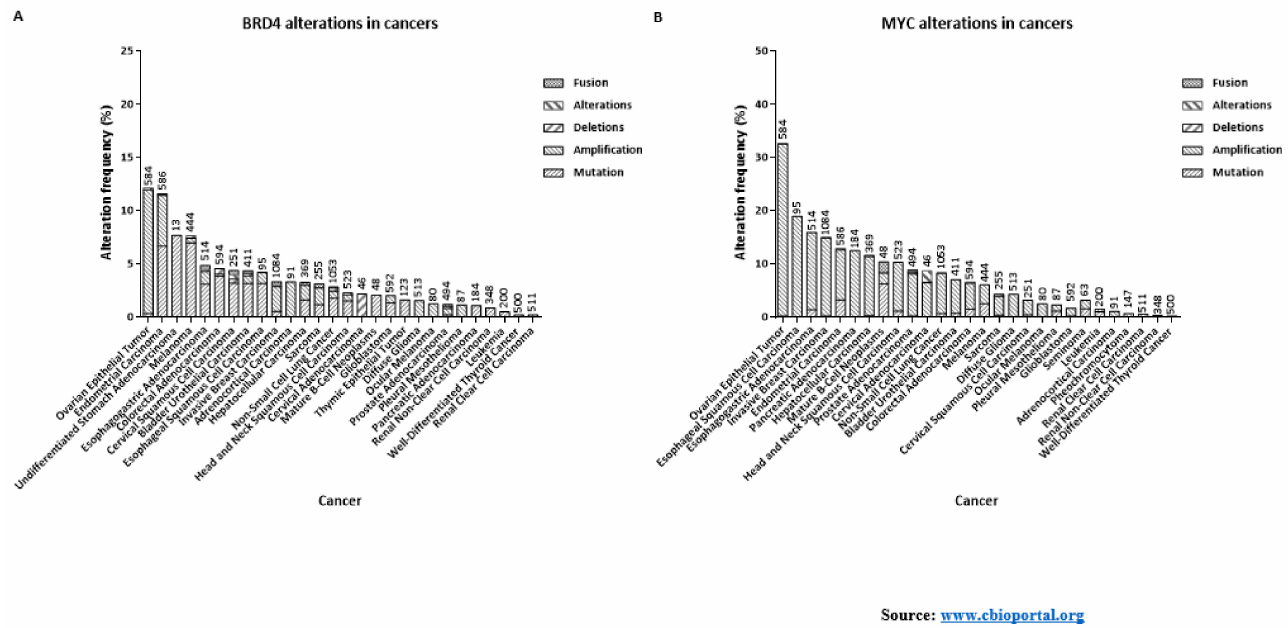
Figure 6. The alterations of the ( A ) BRD4 and ( B ) MYC genes in various cancer entities. The alteration frequency of the BRD4 and MYC genes in various cancers have been represented graphically. The alterations involve deletions, mutations, copy number amplifications, other alterations and fusions. The numbers on top of each cancer entity are the respective patient numbers represented. The data were obtained from www.cbioportal.org. (Accessed on 21 February